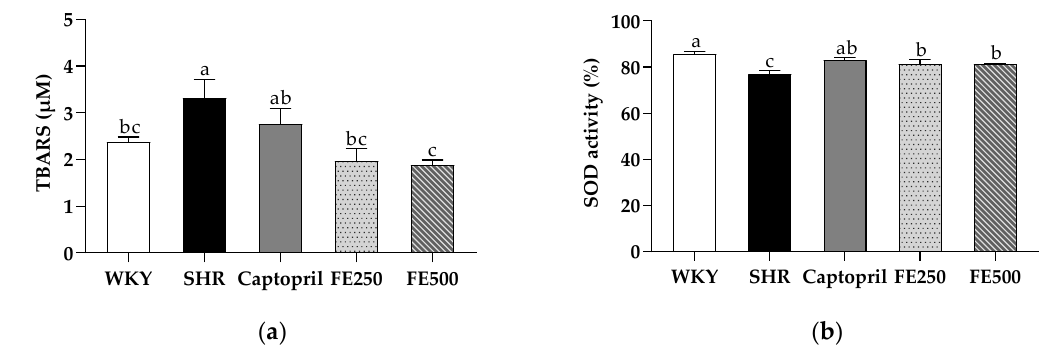
Figure 1. TBARS concentration in the plasma ( a ) and SOD activity in the serum ( b ) in the SHRs after 8 weeks of oral administration. TBARS, thiobarbituric acid reactive substance; SOD, superoxide dismutase; WKY, Wistar Kyoto rats; SHR, Spontaneously hypertensive rats; Captopril, SHRs treated with 50 mg/kg bw of captopril; FE250, SHRs treated with 250 mg/kg bw of FE; FE500, SHRs treated with 500 mg/kg bw of FE; FE, finger millet ethanol extract. Data are expressed as means ± standard errors of the mean ( n = 6). Different letters above the bars indicate significant differences at p < 0.05.